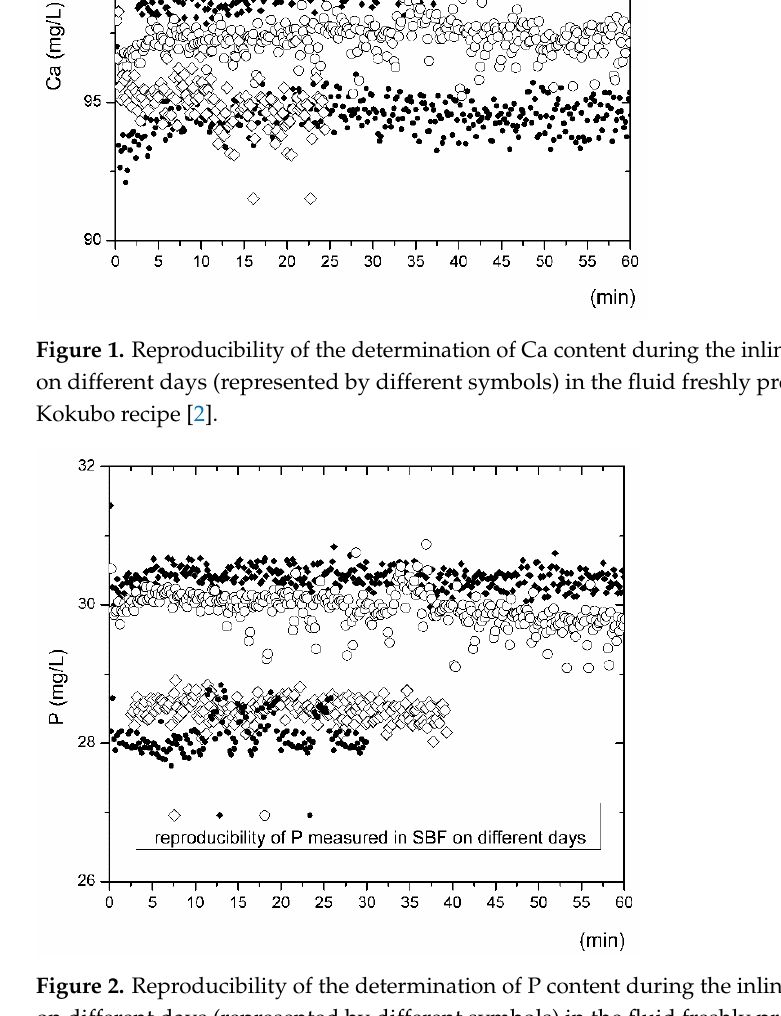
Figure 2. Reproducibility of the determination of P content during the inline ICP tests as measured on different days (represented by different symbols) in the fluid freshly prepared according to the Kokubo recipe [2].